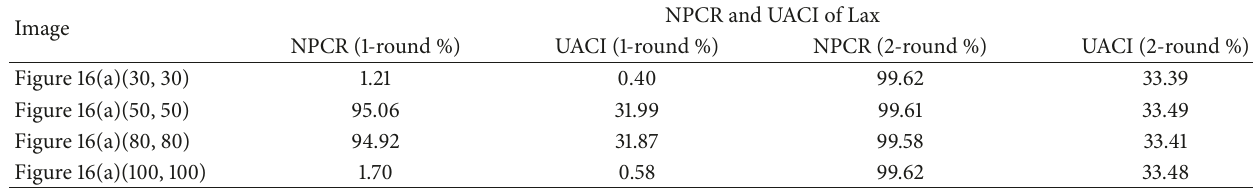
Table 14: NPCR and UACI between cipher-images with slightly different plain-images. Image